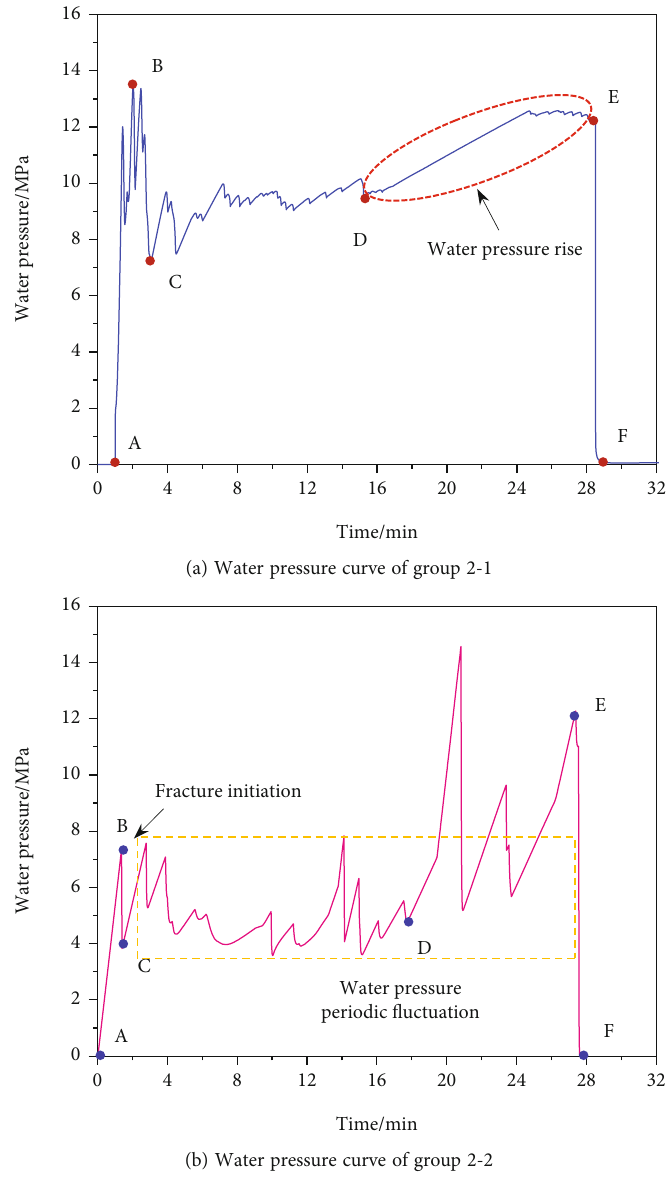
Figure 17: Water pressure curve of composite layered rock under di ff erent injection